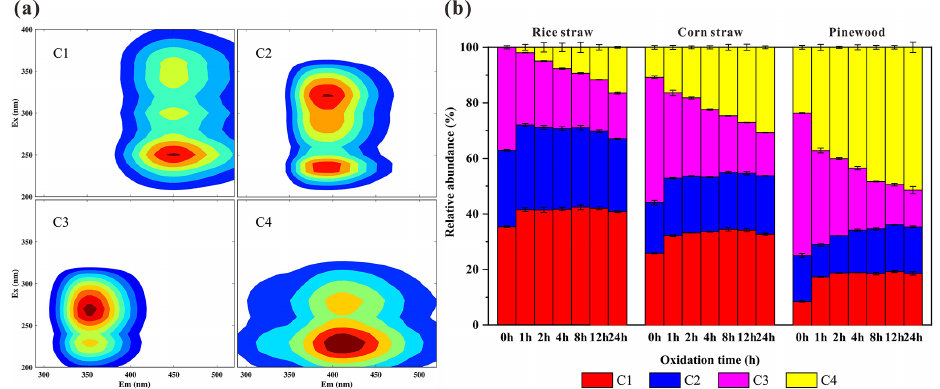
Figure 4. (a) Three fluorescent components of the BB BrC identified by the EEM–PARAFAC model. (b) Variations in the abundances of the individual fluorescent components (C1–C4) within the water-soluble BrC in RS, CS, and PW smoke particles during the ozone aging process. The fluorescent spectra of components C1–C4 are listed in the upper layer, and the corresponding loading positions and identification are shown in Table